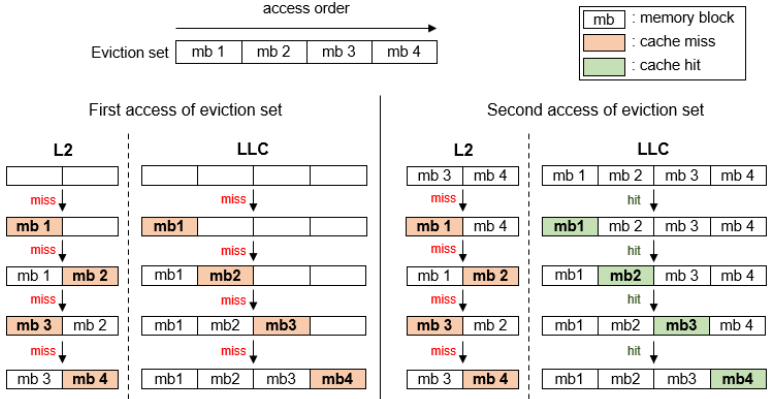
Figure 2. Impact of accessing an eviction set on L2 cache and LLC with LRU replacement